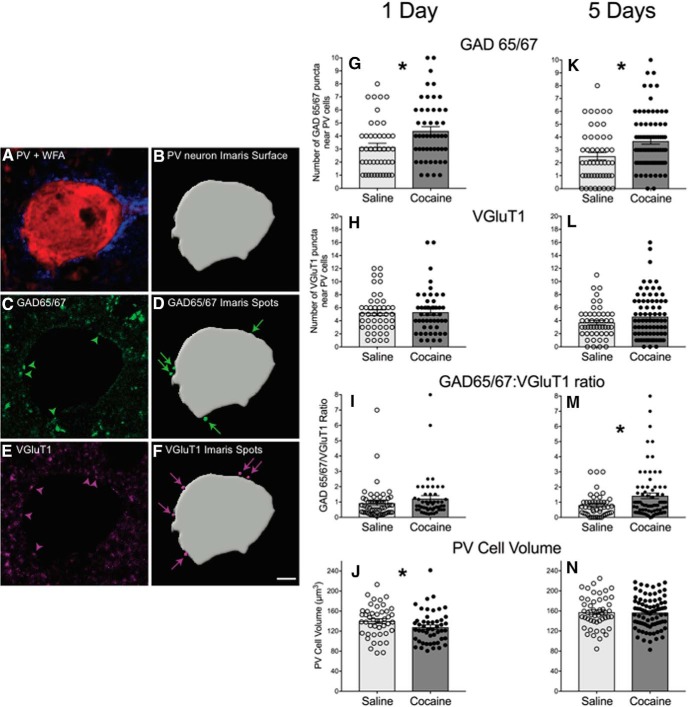
Cocaine alters intensity of GABAergic (GAD65/67) puncta near PV neurons surrounded by PNNs in the prelimbic PFC. Cells were visualized with confocal microscopy and analyzed using Imaris segmentation tools. A, Representative PV neuron (red) surrounded by a PNN labeled with WFA (blue). B, The PV neuron is traced and a surface is created. C, The Mask Channel function was used to isolate GAD65/67 labeling to the area outside of the PV neuronal surface, and GAD65/67-labeled puncta (green arrowheads) were identified. D, GAD65/67-labeled puncta (green arrowheads) were then thresholded using the Imaris Spots tool. Spots that met the size criteria and were located adjacent to the PV neuron surface were included in the analysis (green arrows). E, F, VGluT1-labeled puncta (magenta arrowheads) were segmented separately using the same protocol (E), and VGluT1 spots meeting our size and location criteria were included in the analysis (magenta arrows; F). G–I, One day of cocaine exposure increases GAD 65/67 puncta (saline, N = 3, 45 cells; cocaine, N = 3, 49 cells; G), no change in VGluT1 puncta (H), and a trend toward an increase in the ratio of GAD65/67 to VGluT1 puncta (I). J, One day of cocaine exposure decreases PV cell volume. K–M, Five days of cocaine exposure increases GAD 65/67 puncta (saline, N = 4, 49 cells; cocaine, N = 6, 78 cells; K), yields no change in VGluT1 puncta (L), and increases the ratio of GAD65/67 to VGluT1 puncta (M). N, Five days of cocaine exposure does not alter PV cell volume. Data from bar graphs are the mean ± SEM. Scale bar, 3 µm. *p < 0.05 and #p < 0.1, compared with saline controls.